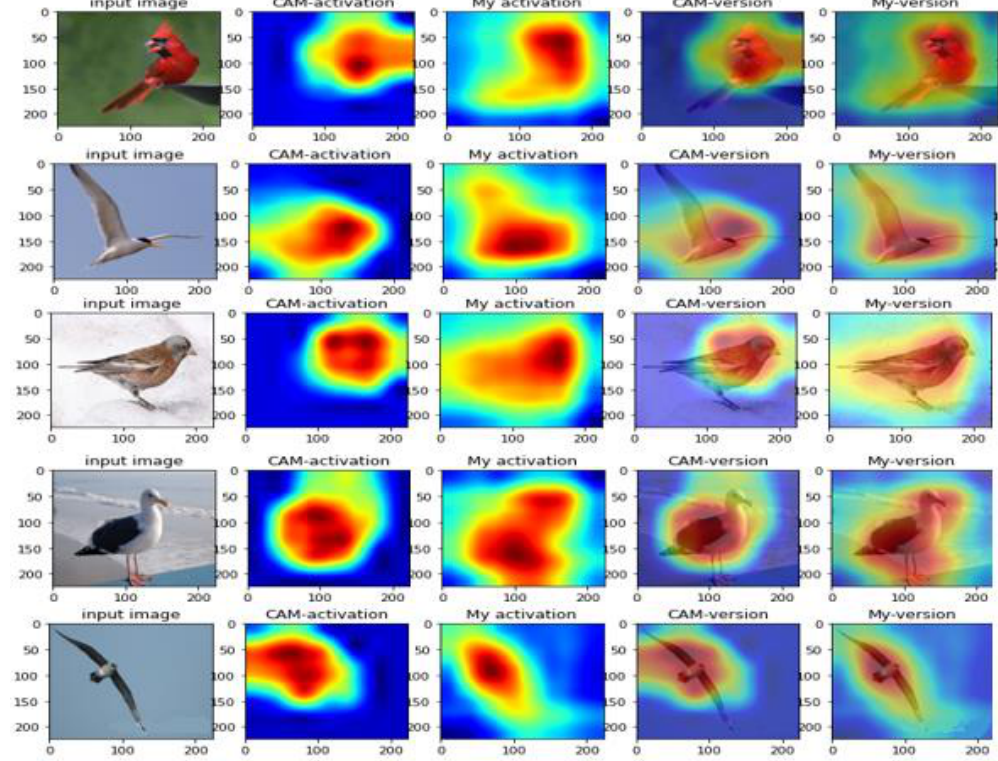
Figure 1. Sub-optimal localization problems: using the CAM [1] method alone, birds’ tails, wings, and legs are not local- ized.